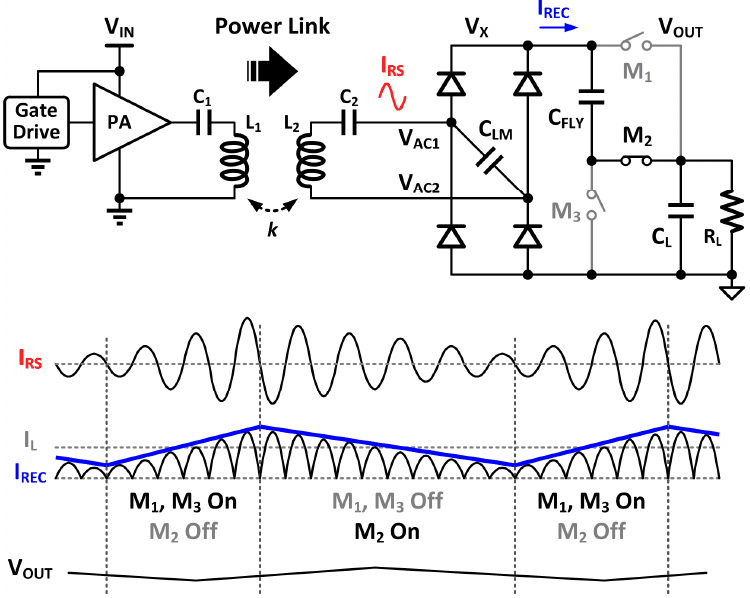
Figure 8. A resonant WPT system with a pulse-width modulation regulating rectifier and a step-down charge pump [17].